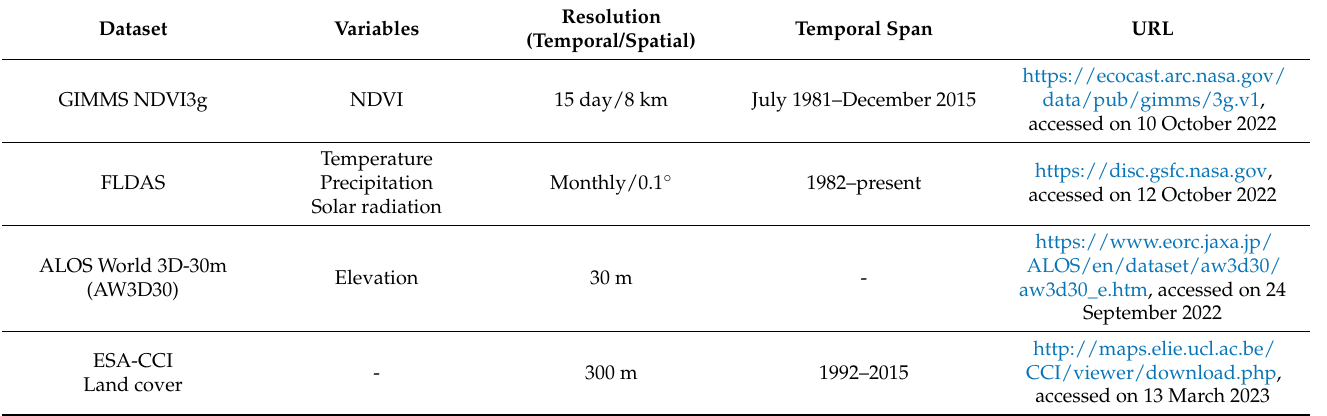
Table 1. Data sources and